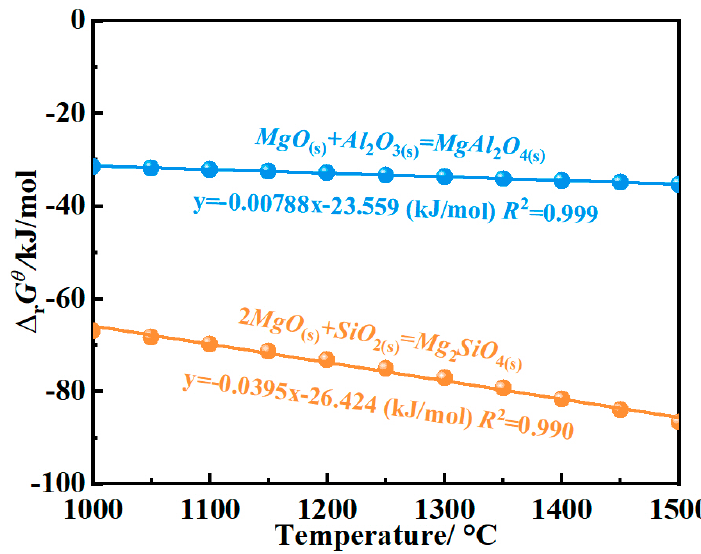
Figure 4. The Δ r G θ of reactions at 1000~1500 °C. The change in mass of the samples would be influenced by the oxidation of graphite, carbide, and nitride [10,18,38]. Thermogravimetric (TG) analysis was carried out in order refractories. As shown in Figure 5, the TG curves remained stable at 600 ◦ C, and the mass loss observed above 600 ◦ C could be attributed to the oxidation of graphite. As the temperature rose to 941 ◦ C, the TG value of sample ASM5 reached its minimum, i.e., 94.5%. While sample ASM0 had a higher transition temperature (1009 ◦ C) and a lower TG value (93.2%). At 1200 ◦ C, the TG values of sample ASM0, ASM2, and ASM5 were 94.4%, 95.5%, and 96.1%, respectively. This further proved that the content of the generated Mg 2 SiO 4 and MgAl 2 O 4 after the oxidation increased with the in situ Mg-sialon.